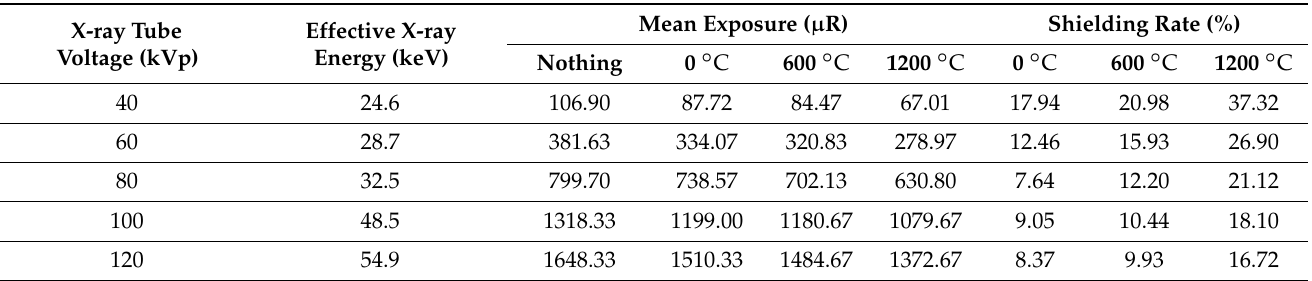
Table 2. Comparison between the shielding efficiencies of oyster shell-based shielding sheets fabri- cated with and without plastic working.